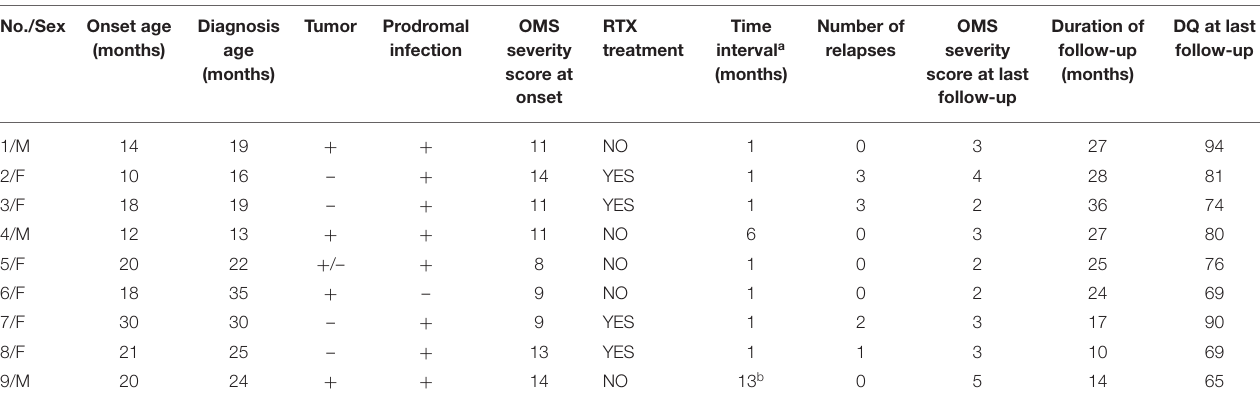
TABLE 2 | Clinical features, treatment, and prognosis of children with OMS ( N = 9). No./Sex Onset age